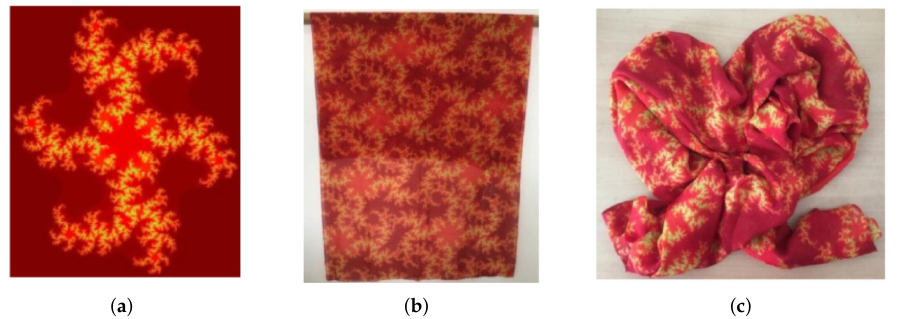
Figure 29. Pattern design of garment fabrics (Wang et al. [56]). ( a ) Basic pattern, ( b ) Physical figure 1, and ( c ) Physical figure 2.